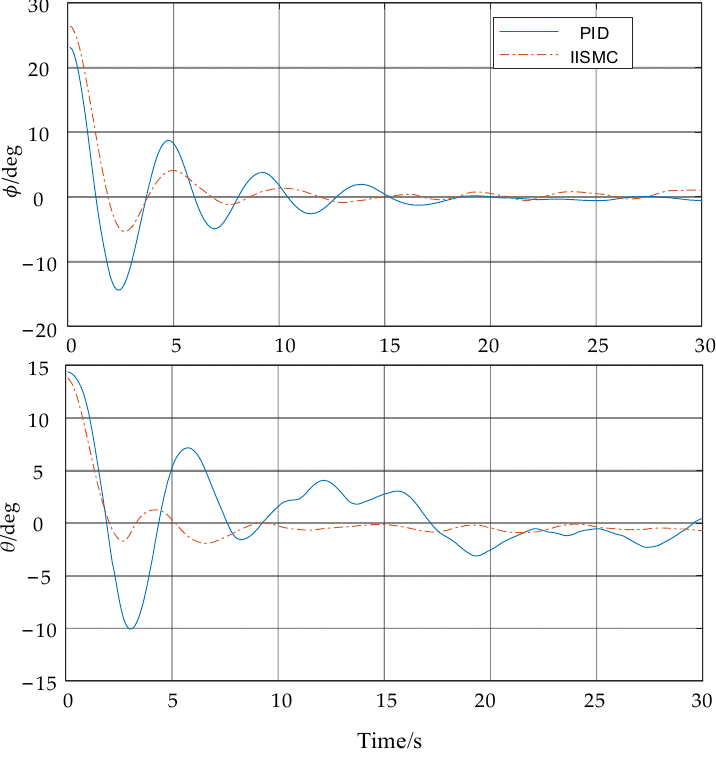
Figure 20. The attitude angles under PID and IISMC controllers.